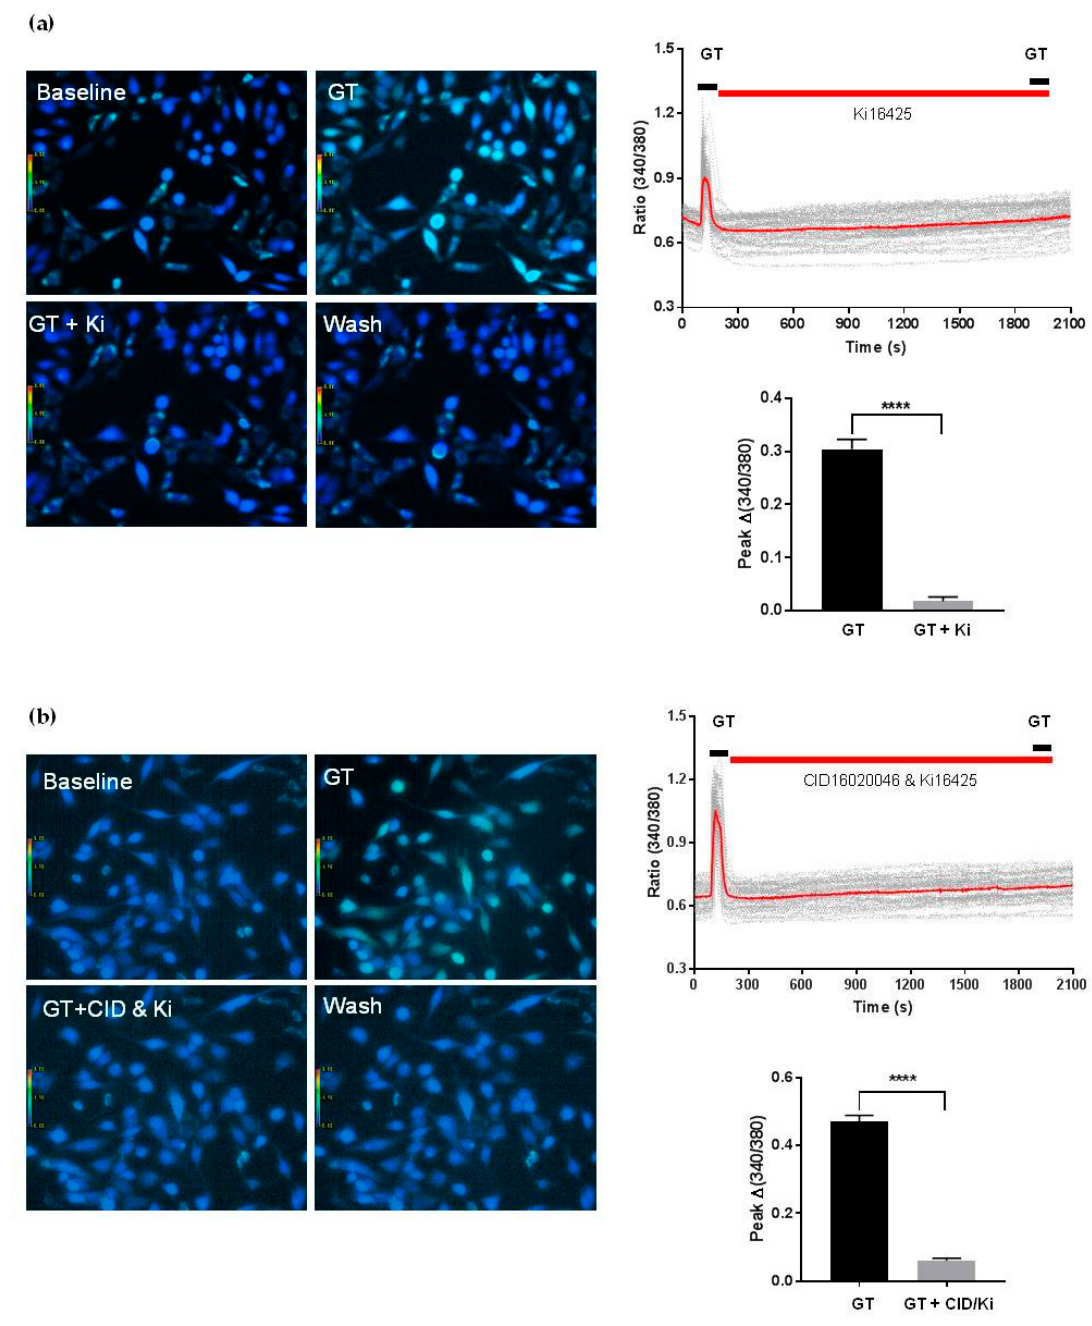
Figure 6. E ff ects of the LPA1 / 3 antagonist Ki16425 ( a ) alone and co-treatment with Ki16425 and the GPR55 antagonist CID16020046 ( b ) on gintonin (0.1 µ g / mL)-mediated [Ca 2 + ] i transients in PC-3 cells. Analyses of calcium signal localization were performed, as described in Figure 5. Left panel ( a , b ): representative pictures of [Ca 2 + ] i levels in PC-3 cells in the absence or presence of Ki16425 (10 µ M) or CID16020046 (10 µ M) plus Ki16425. Upper right panel: representative peaks of [Ca 2 + ] i transients in the absence or presence of Ki16425 or CID16020046 (10 µ M) plus Ki16425. Lower right panel ( a , b ): histograms of the e ff ects of Ki16425 or CID16020046 (10 µ M) plus Ki16425 on gintonin (0.1 µ g / mL)-mediated [Ca 2 + ] i transients. Data were obtained from 40–50 di ff erent cells in three independent experiments. Data represent means ± SD. **** p < 0.0001, compared to the presence of inhibitor (Ki16425, Ki, or CID16020046 plus Ki). GT,